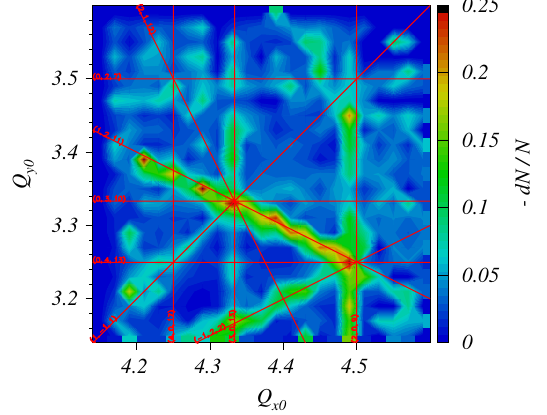
FIG. 4. Experimental resonance chart of SIS18. The colors represent the normalized beam loss between two consecutive data acquisitions (10 ms) during several tune scans each 1 s long [25]. In these measurements the chromaticity was left uncompensated.